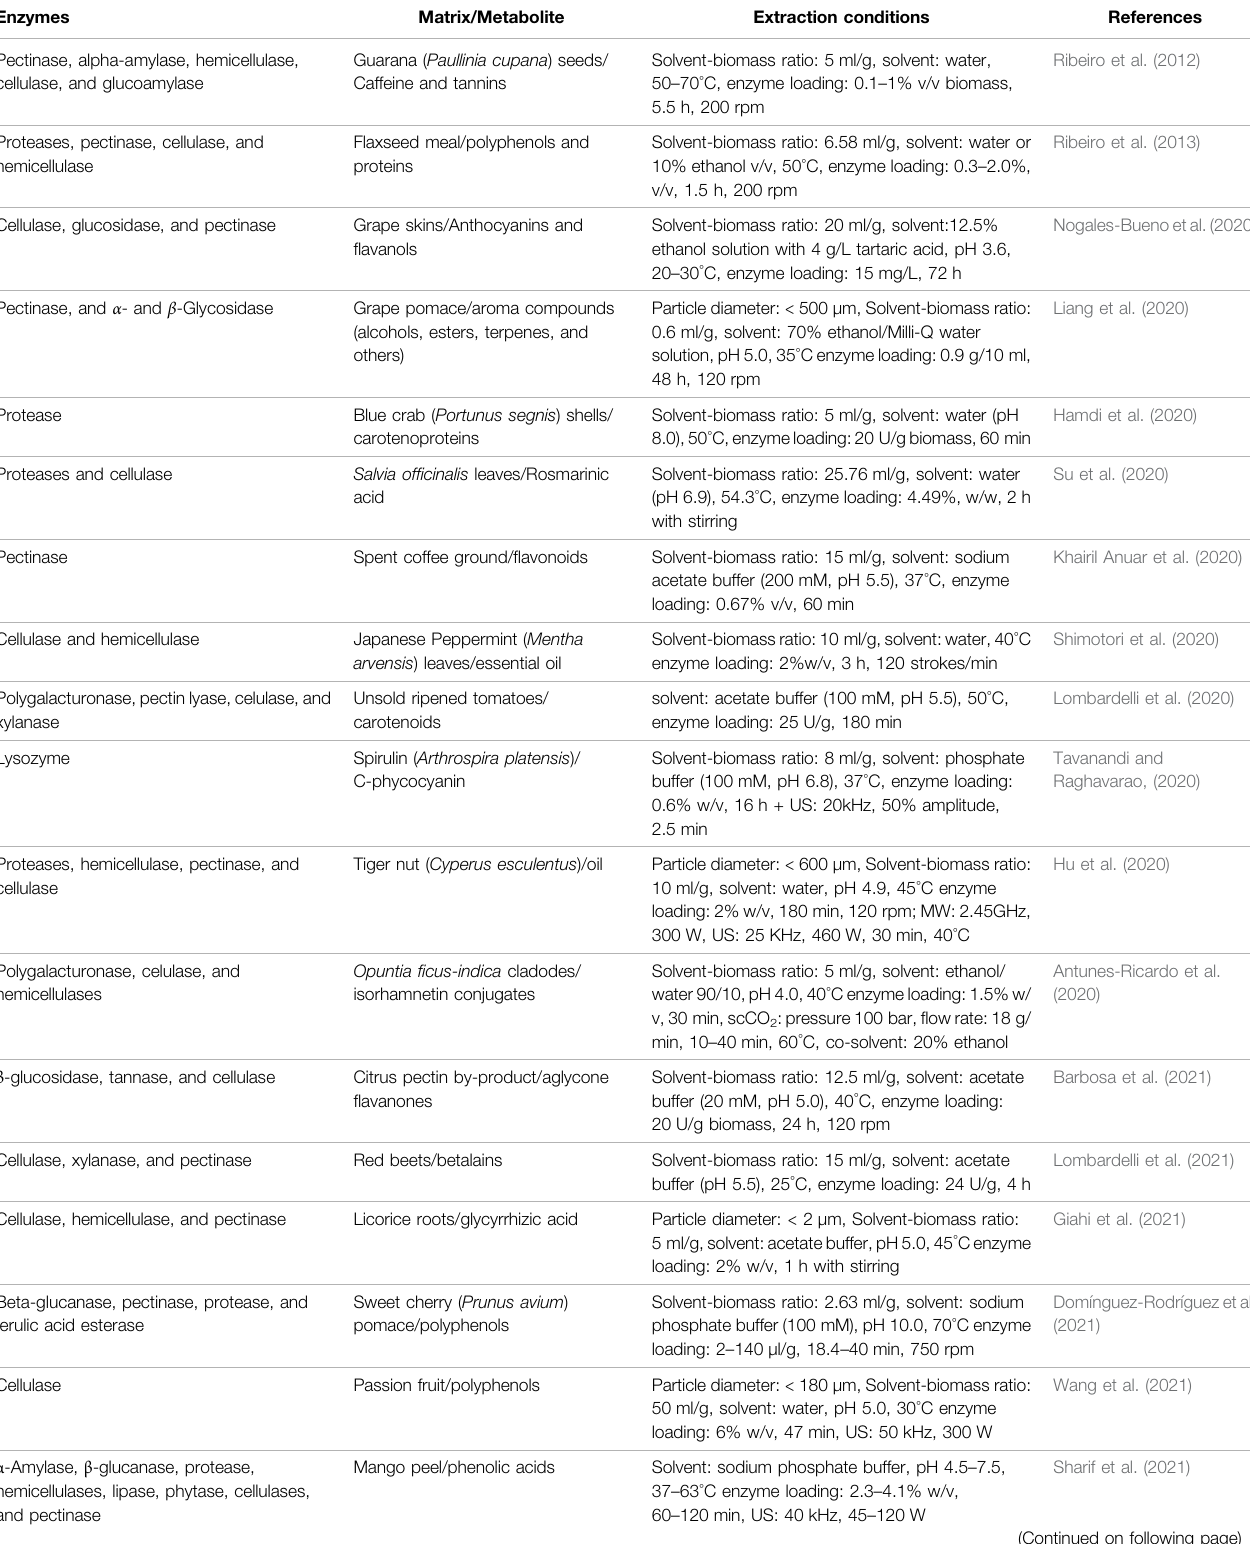
TABLE 1 | Examples of enzyme-assisted extraction of bioactive compounds from agroindustrial